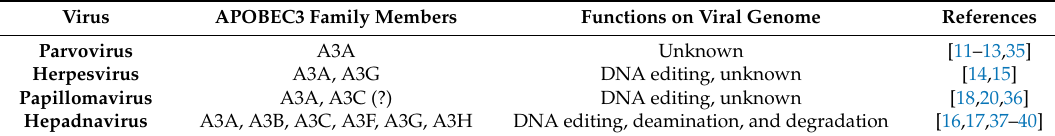
Figure 1. Structural features of the human apolipoprotein B messenger RNA-editing, enzyme-catalytic, polypeptide-like 3 (APOBEC3s). ( A ) APOBEC3 family members convert cytosine to uracil and induce DNA degradation or mutations if the APOBEC3-mediated conversion of cytosine to uracil is not repaired; ( B ) All APOBEC3 family members are arrayed in tandem on chromosome 22; ( C ) Schematic of APOBEC3 family members containing one or two cytidine deaminase (CD) domains. The catalytically active (green) and inactive (red) cytidine deaminase domains are pictured. The conserved zinc-coordinating motif is pictured between dashed lines. Table 1. Restriction of DNA viruses by APOBEC3 family members.